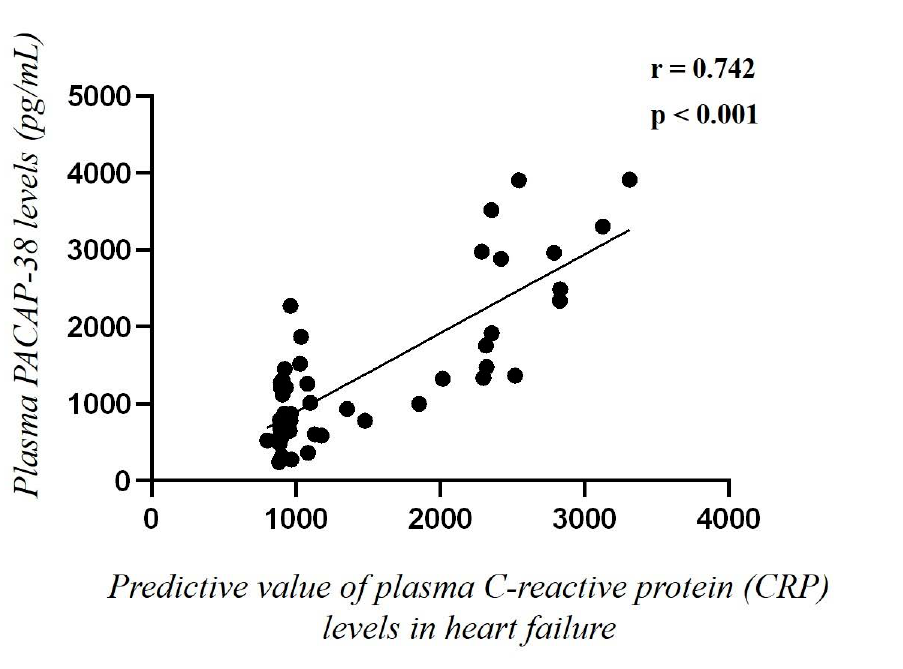
Figure 3. Correlation between the predictive value of C-reactive protein (CRP) (mg/mL) and plasma PACAP-38 levels (pg/mL) with multivariate analysis, also taking the type of heart failure into account (acute or chronic) ( n = 46). Statistical analysis was performed with Spearman’s correlation.